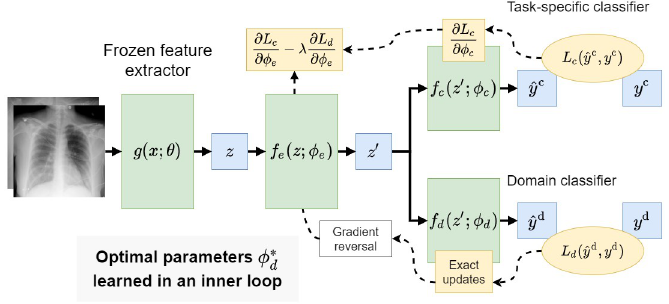
Fig 1. Overview of the feature disentanglement modeling approach. We propose to learn a model that simultaneously predicts the class label and domain label for a given CXR image. The parameters of the model are updated to extract representations that contain information about the class label but not about domain